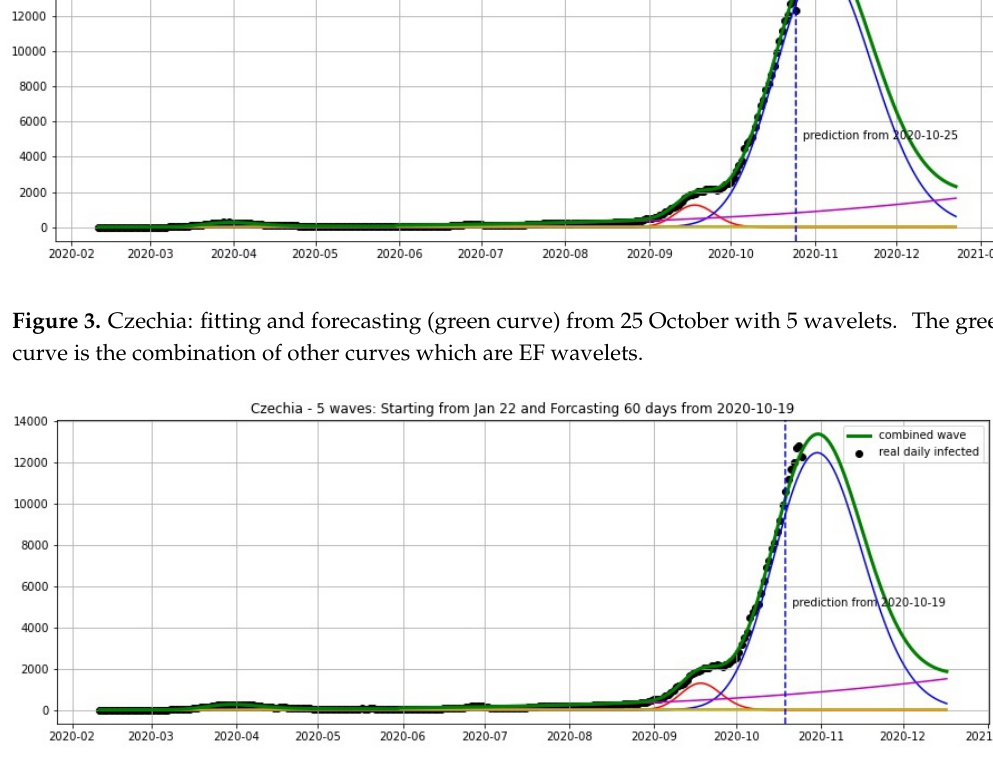
Figure 4. Czechia: fitting and forecasting from 19 October with 5 wavelets. The green curve is the combination of other curves which are EF wavelets.